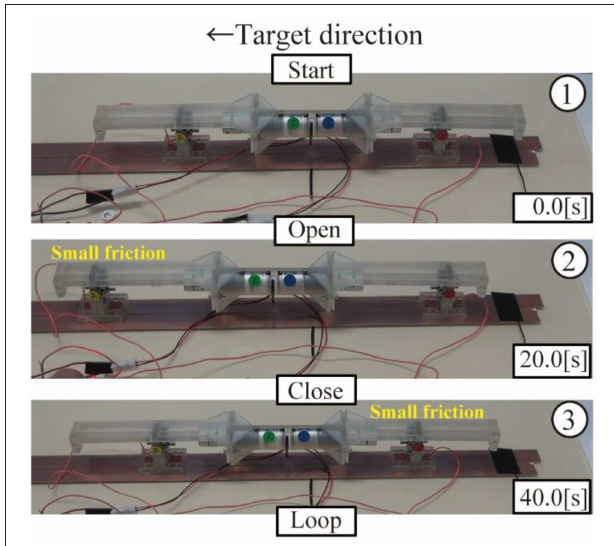
FIGURE 5 | Sequential walking motion of the inchworm search robot.